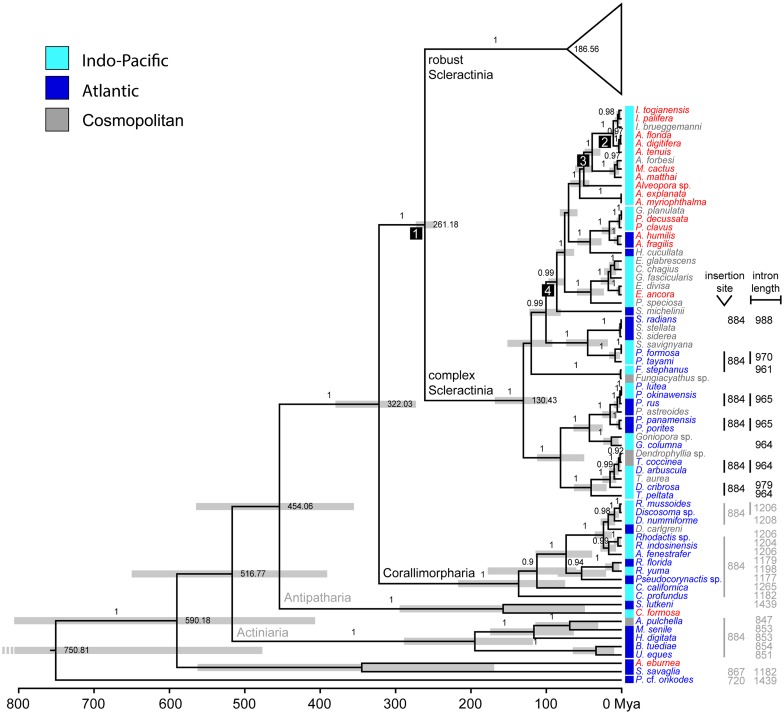
Molecular-clock analysis of major cnidarian groups and complex Scleractinia.A set of eight fossil calibration points was used as suggested by Simpson et al. [53]. Nodes used for calibration are denoted with numbered black boxes referring to the node numbers used in the Methods section. Posterior probabilities are indicated at branches. Bars at nodes indicate 95% credibility intervals. Taxa are color-coded according to the absence (red) or presence (blue) of an intron or whether no information is available (gray).The order Scleractinia is a highly supported monophyletic group, with the order Corallimorpharia being its sister group.